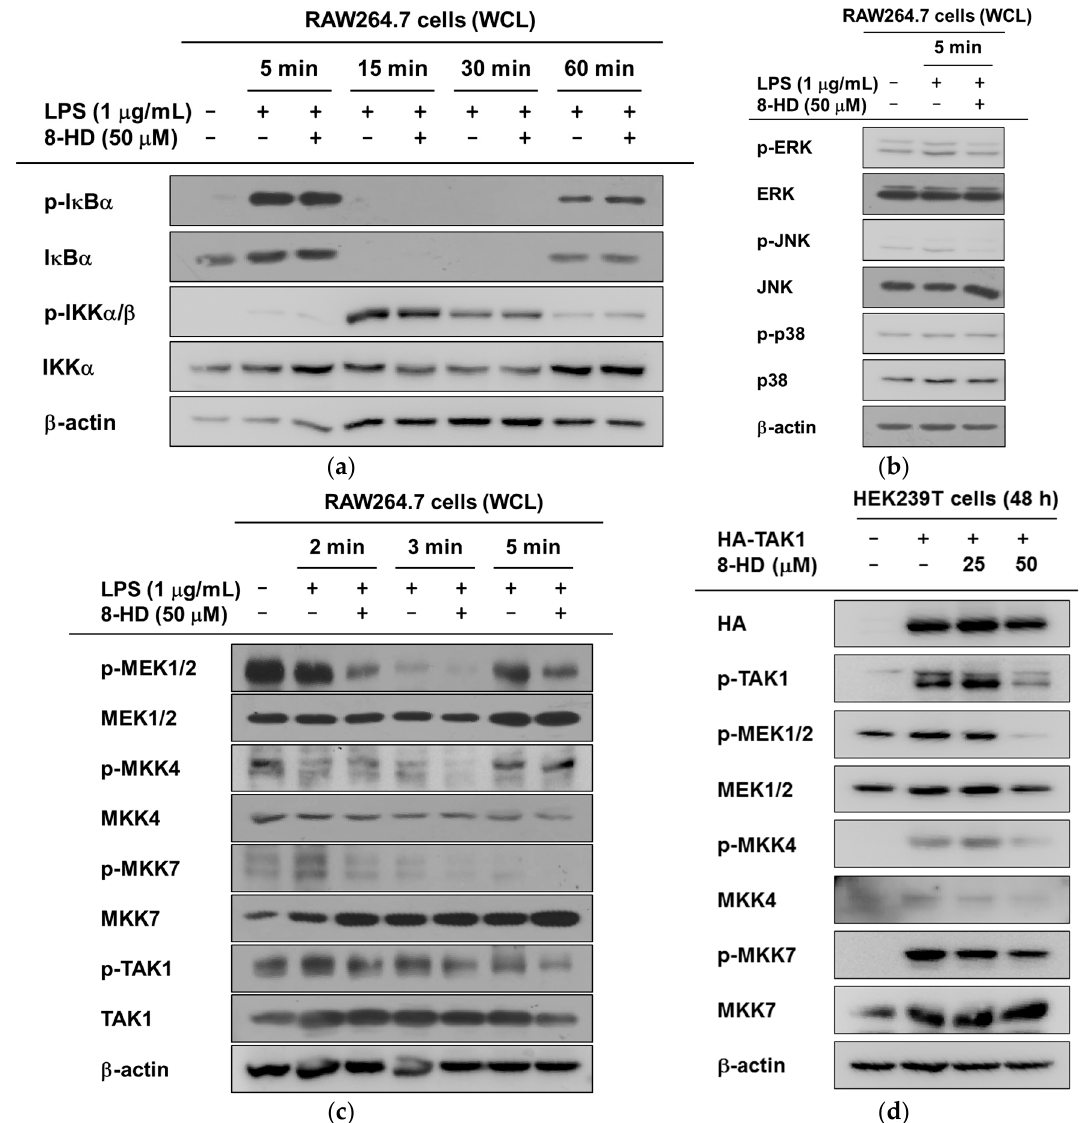
Figure 5. The effects of 8-HD on the NF- κ B and AP-1 signaling pathways. ( a ) The effect of 8-HD on the NF- κ B signaling pathway using LPS-treated RAW264.7 cell lysates. The phosphorylated forms of NF- κ B inhibitory protein (I κ B α ) and IKK α / β were determined by immunoblotting. ( b ) The effect of 8-HD on the activator protein 1 (AP-1) signaling pathway using whole cell lysates. The phosphorylated levels of the mitogen-activated protein kinases (MAPKs; ERK, JNK, and p38) were measured by immunoblotting. ( c ) RAW264.7 cells were pre-treated with 8-HD for 30 min, and LPS was then applied for different time points (2, 3, and 5 min). The phosphorylated levels of MAPK/ERK kinase 1/2 (MEK1/2), mitogen-activated protein kinase kinase 4 (MKK4), MKK7, and transforming growth factor beta-activated kinase 1 (TAK1) were determined by immunoblotting. ( d ) HA-TAK1 was transfected into HEK293T cells for 24 h. Cells were then incubated for 24 h in the presence or absence of 8-HD. Whole cell lysates were prepared, and immunoblotting was performed. The phosphorylation levels of TAK1, MEK1/2, MKK4, and MKK7 were verified. β -actin was detected as a loading control.